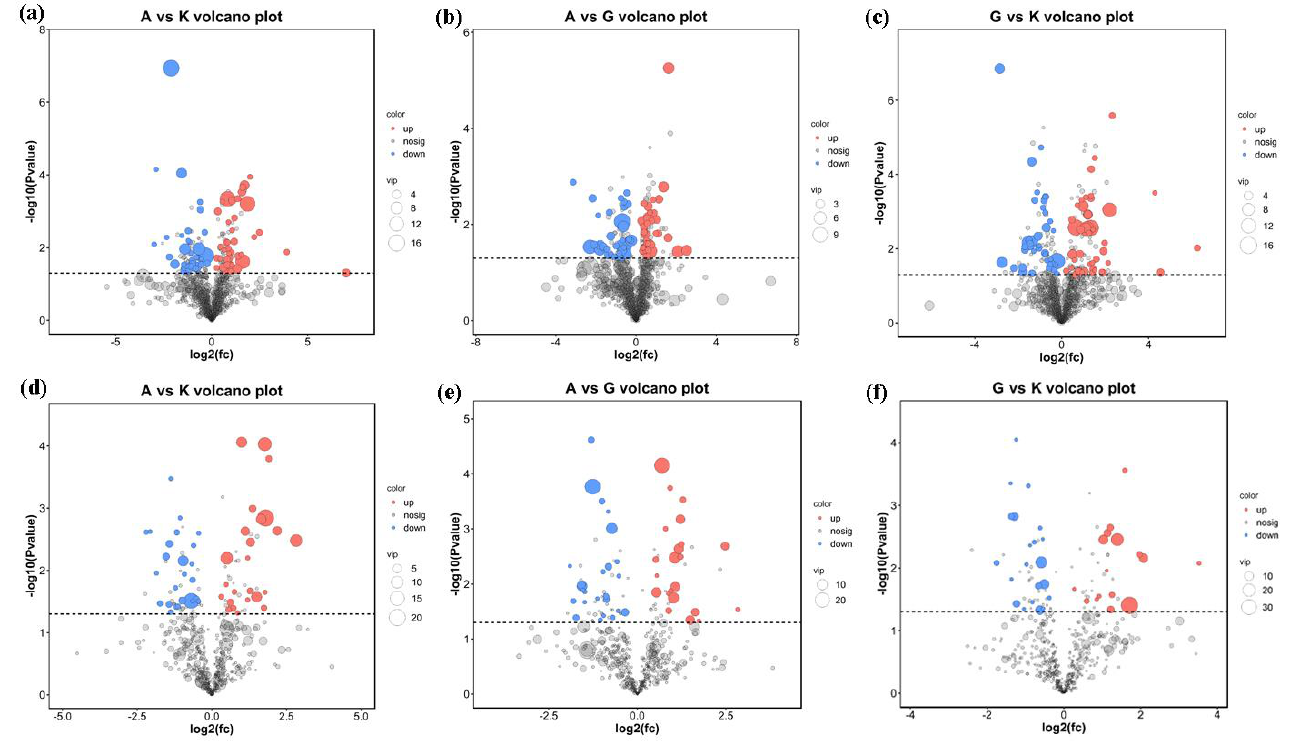
Figure 6. Volcano plot of differential metabolites. (a) The difference of metabolism between groups A and K was analyzed by POS ions; (b) The difference of metabolism between groups A and G was analyzed by POS ions; (c) The difference of metabolism between groups G and K was analyzed by POS ions; (d) The difference of metabolism between groups A and K was analyzed by NEG ions; (e) The difference of metabolism between groups A and G was analyzed by NEG ions; (f) The difference of metabolism between groups G and K was analyzed by NEG ions.